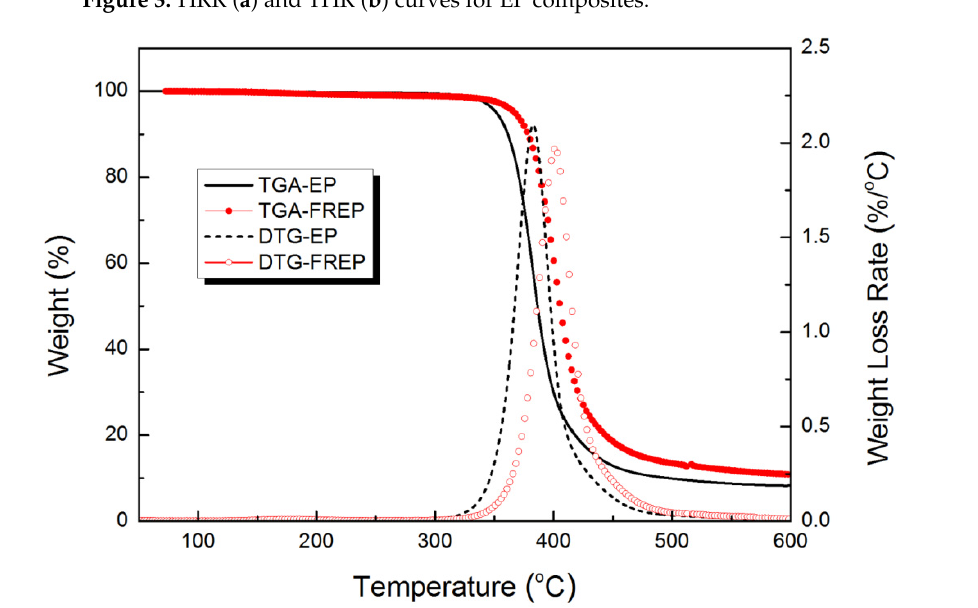
Figure 4. Thermal stability for EP composites. Table 1. TGA data of EP